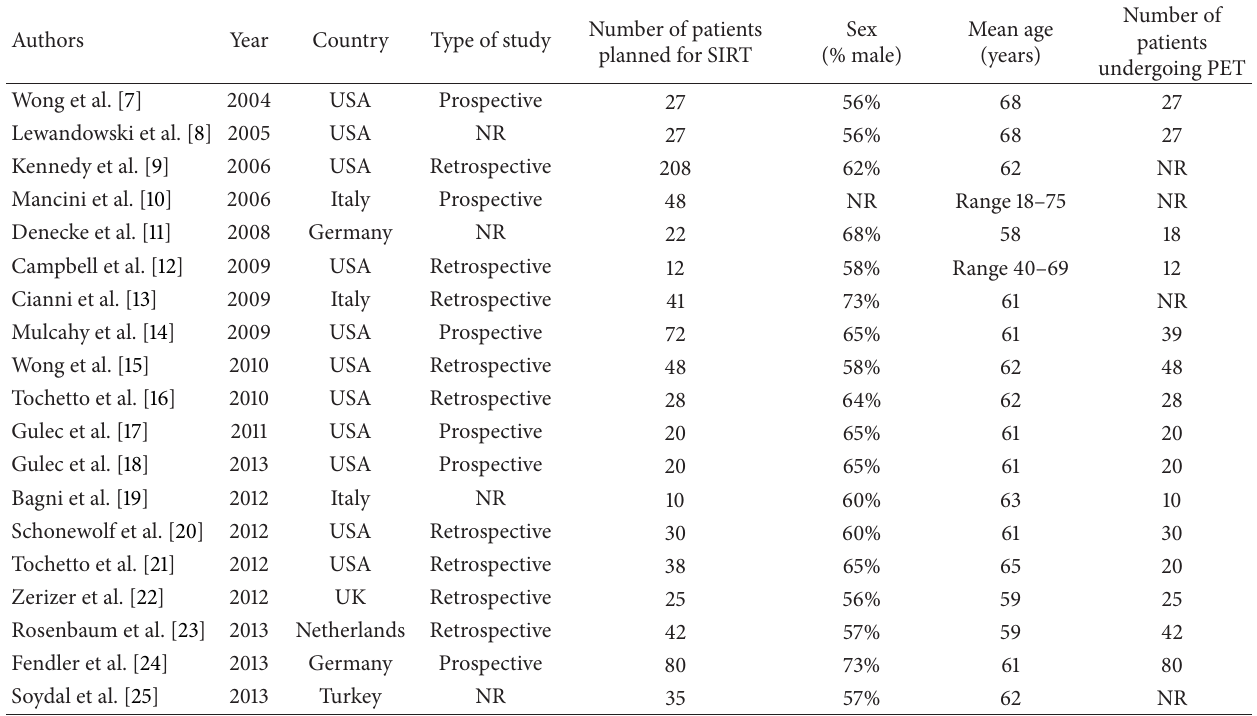
Table 1: Basic characteristics of the included